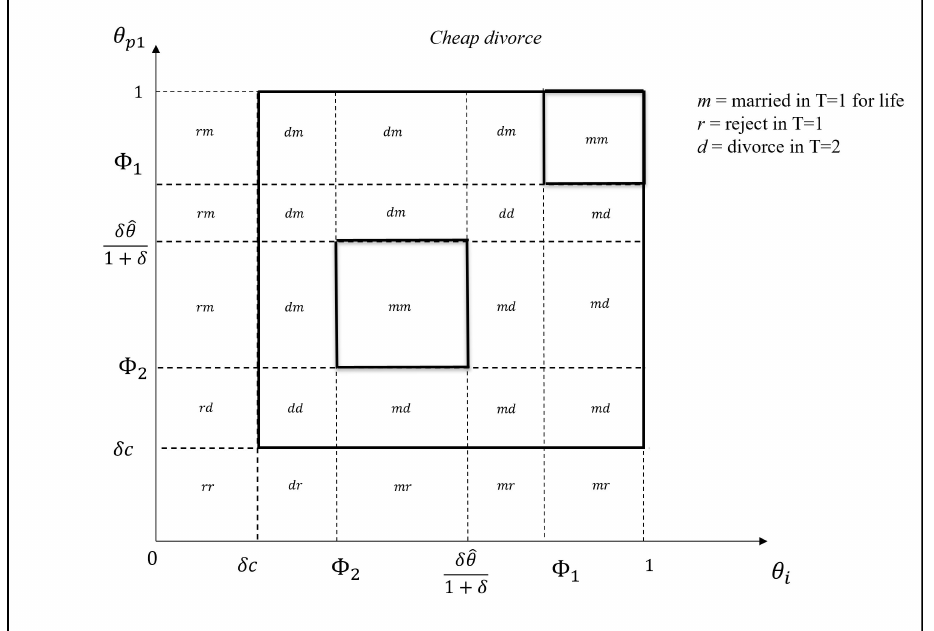
Figure 3. “Cheap divorce” equilibrium configuration—both eligible and non-eligible individuals may